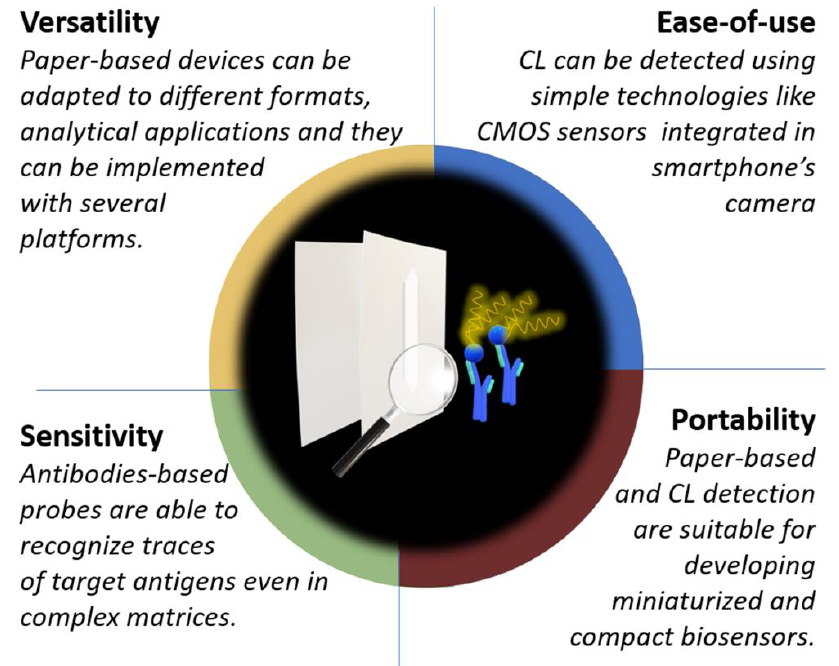
Figure 1. Schema of the advantages obtained by combining paper-based immunosensor with CL detection.